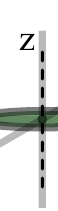
Figure 2: The | 0 〉 quadrupolar state. The disc represents the magnetic dipole fluctuations in the x-y plane, and the dotted line represents a director perpendicular to the plane of fluctuations pointing along the